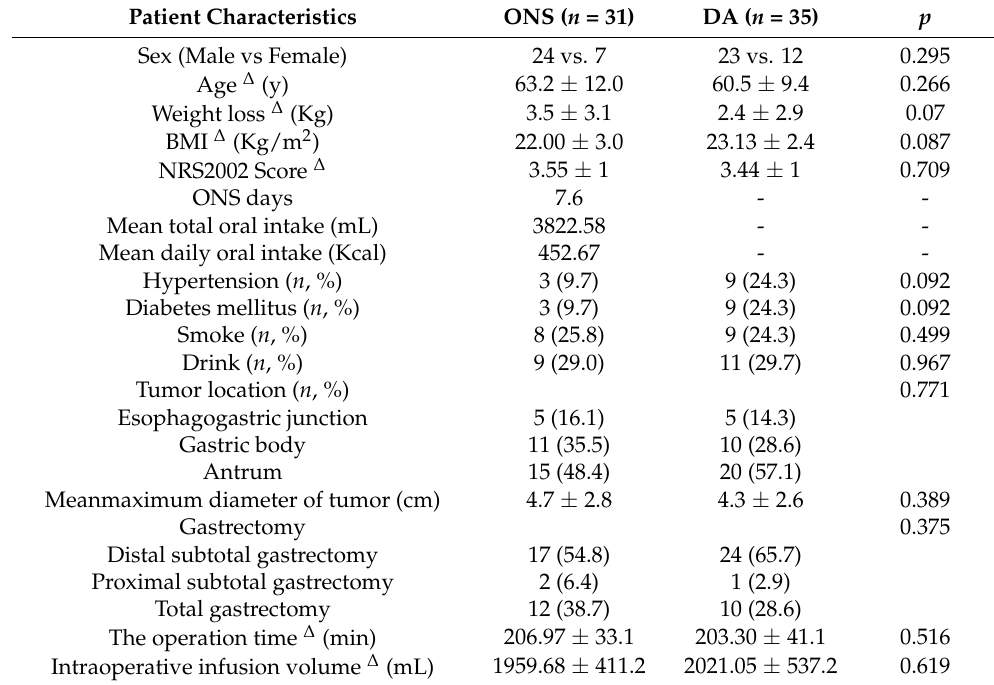
Table 1. Patient